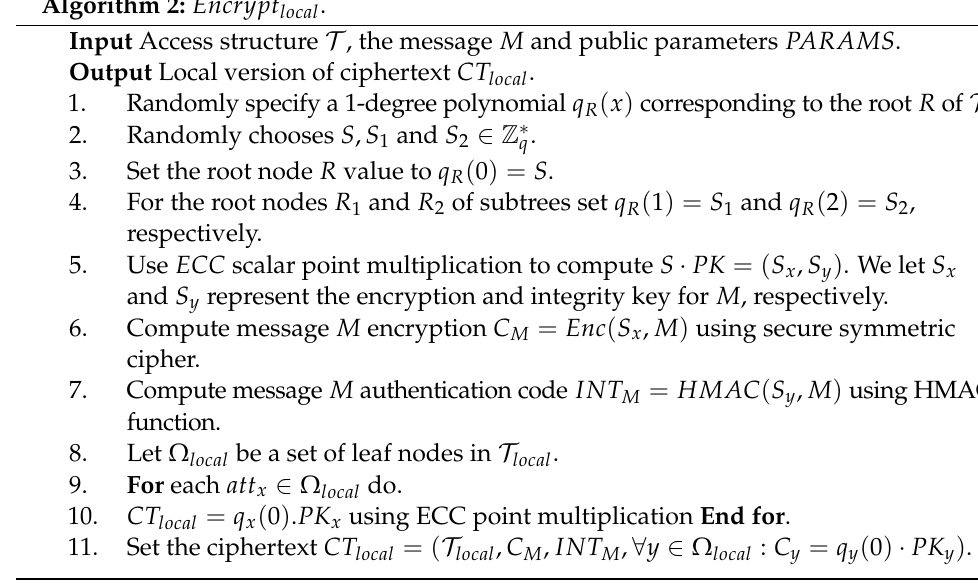
Algorithm 2: Encrypt local .